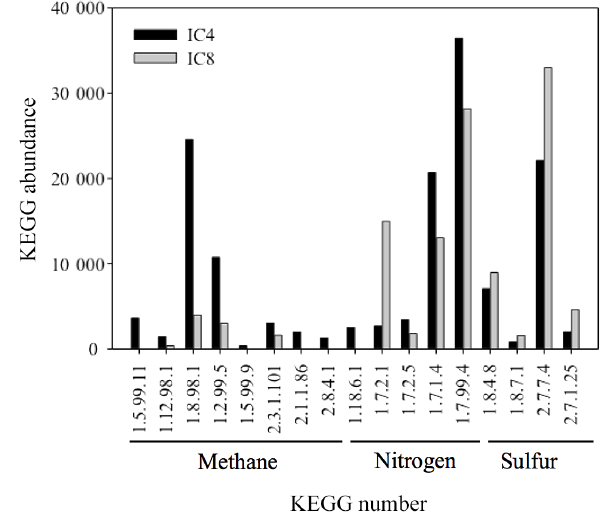
Figure 4. KEGG abundance of the selected functional gene se- quences found within IC4 and IC8 metagenomes. Genes found in low abundance were not included in the figure. Genes from methane, nitrogen, and sulfur metabolic pathways are underlined. The enzyme name that corresponds to each KEGG number is given in Table